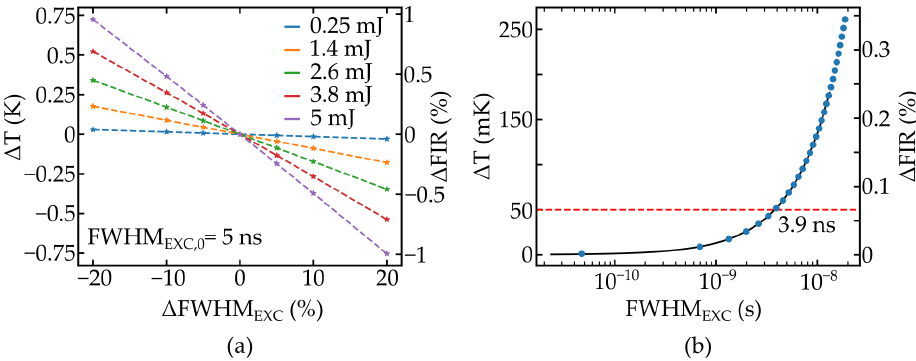
Figure 5. Temporal fluctuations of the excitation pulse width FHWM EXC and the resulting tempera- ture error for the FIR measurement ( a ) and the estimation of the achievable resolution depending on pulse duration ( b